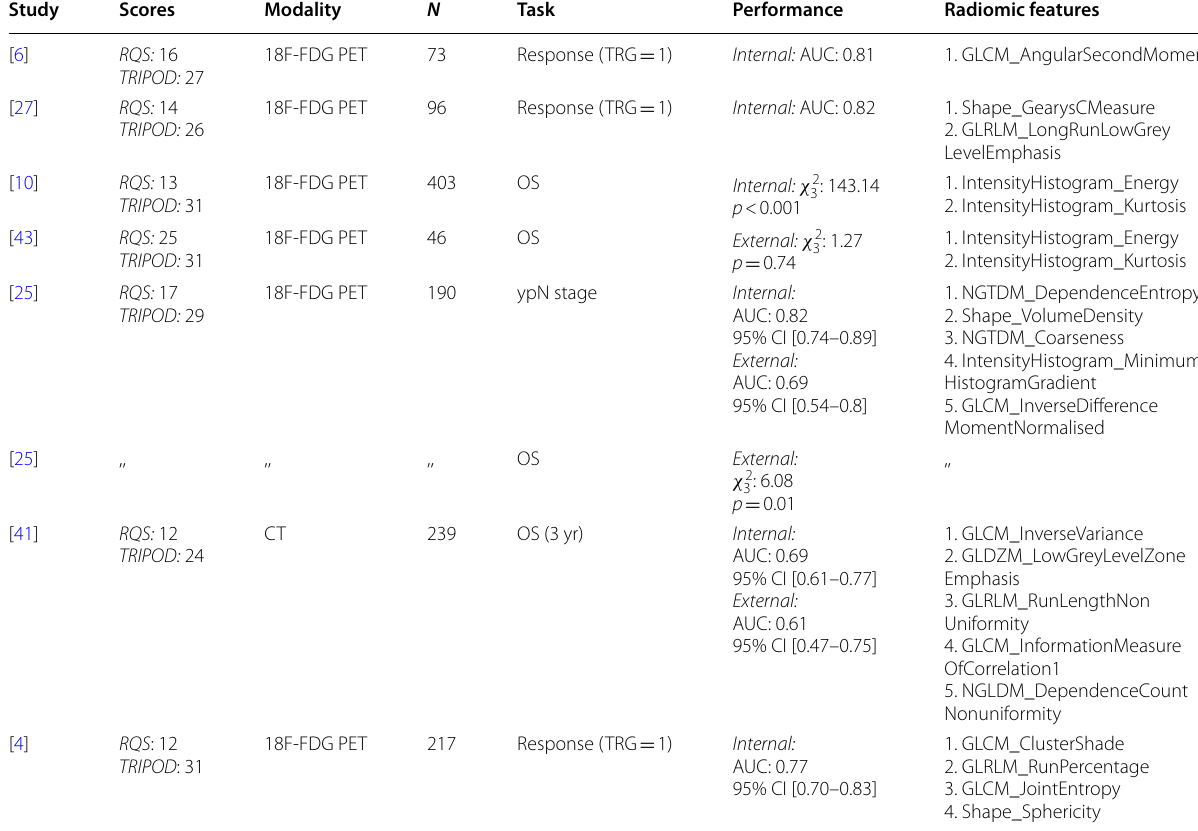
Table 1 Results and predictive features in the seven studies with the highest RQS and TRIPOD